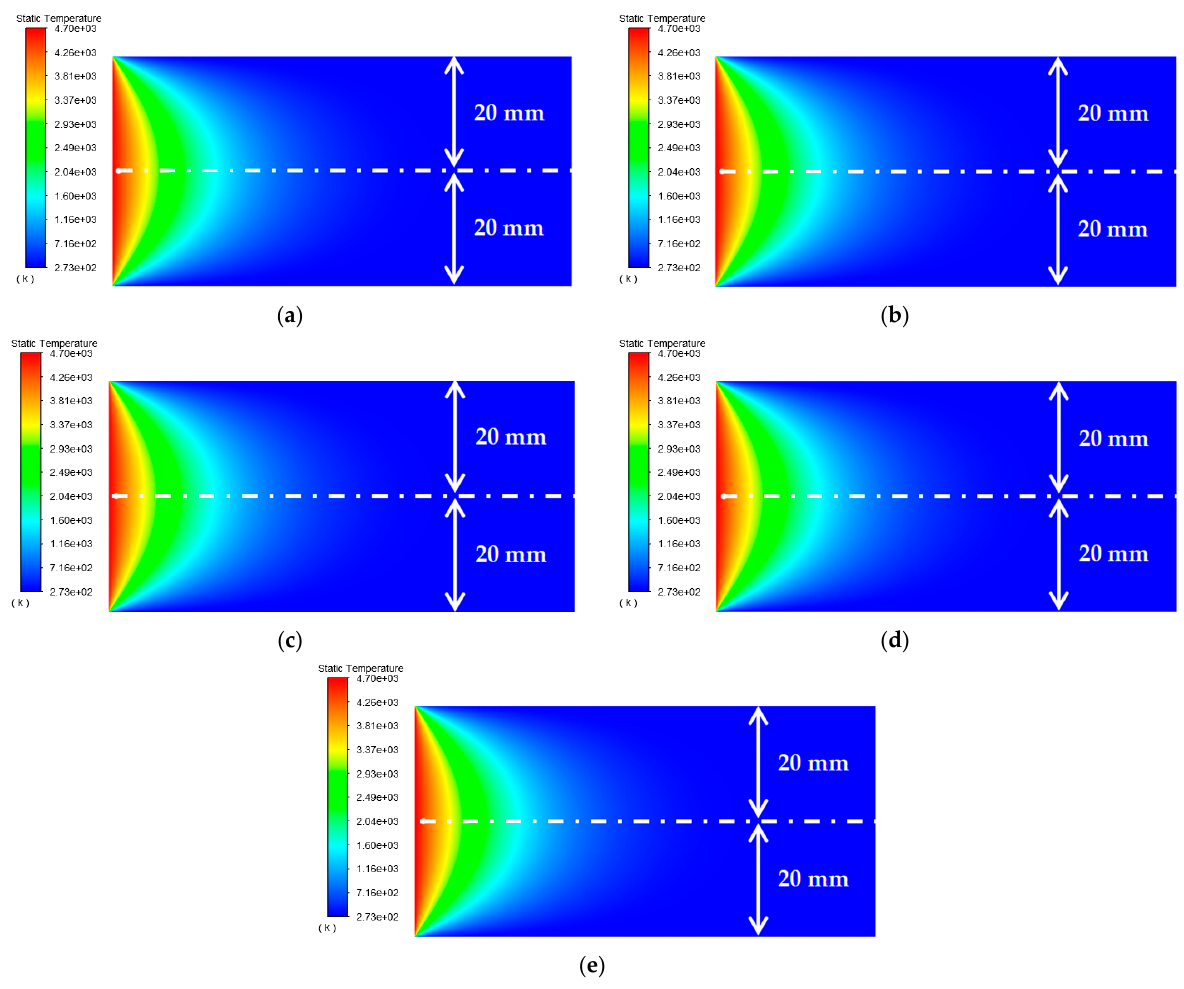
Figure 7. Influence of the distance from the circular through hole to the single surface of the Pt–Rh bushing on the temperature distribution in the Y -axis direction. Table 3. Parameters of circular hole and incident light source in the second simulation.